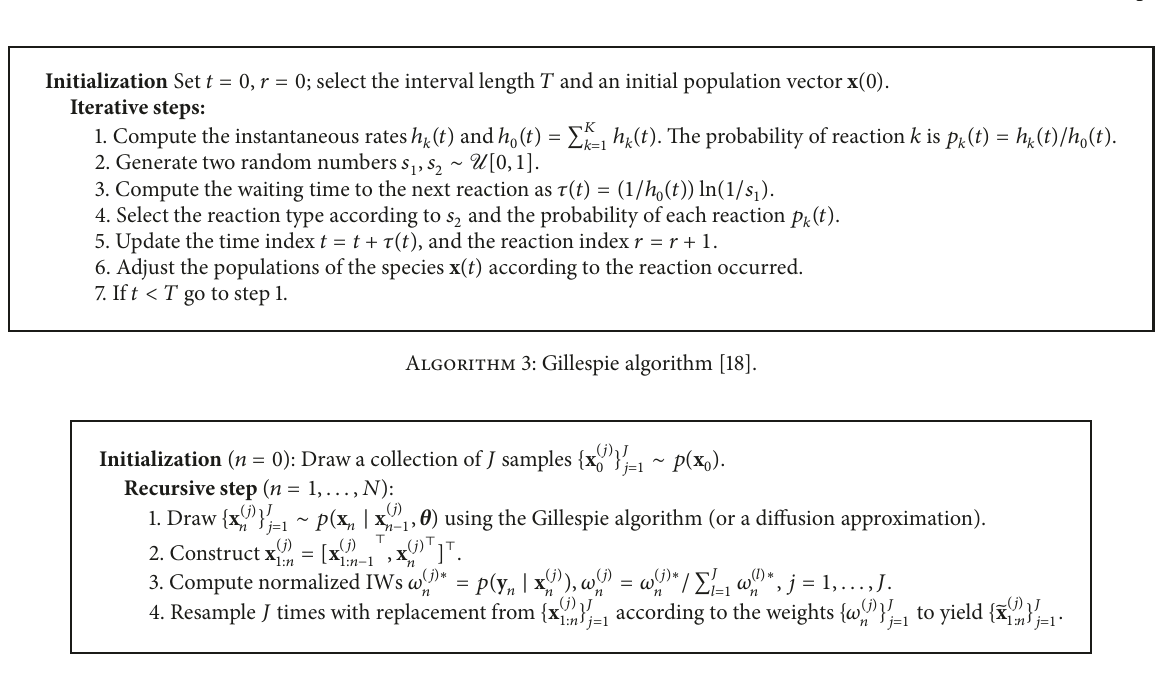
Algorithm 4: Standard particle filter